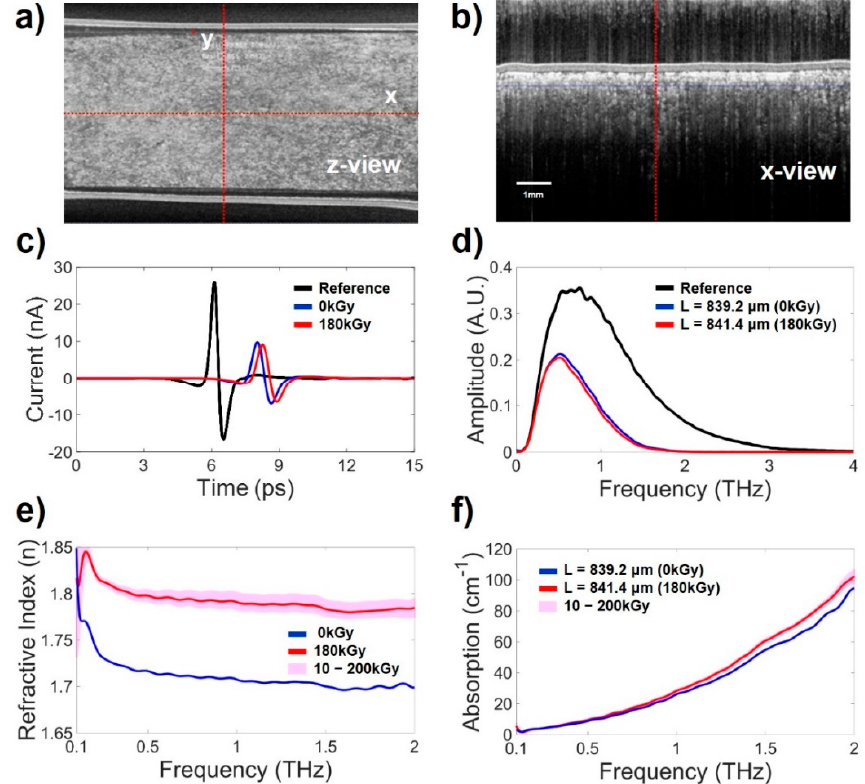
Figure 6. THz measurement results of the thick anti-adhesion films. ( a , b ) are OCT images of the thick film samples. ( c ) Time domain THz pulse signal. ( d ) THz spectrum of ( a ), which is transformed by FFT. The black line represents the THz signal passing through only air as a reference. The blue line represents the THz signal of the noncross-linked film. The red line represents the THz signal of the film cross-linked by irradiation with an E-beam at 180 kGy. ( e ) Calculated refractive indices. ( f ) Calculated absorption coefficients. The blue lines indicate the results of the noncross-linked film (0 kGy). The red lines are the THz measurements of the film cross-linked by irradiation with an E-beam 180 KGy. The pink region are the THz measurements of films cross-linked at dose of E-beam with 10–200 kGy. The variation in THz measurements according to the irradiation dose of the E-beam was small.